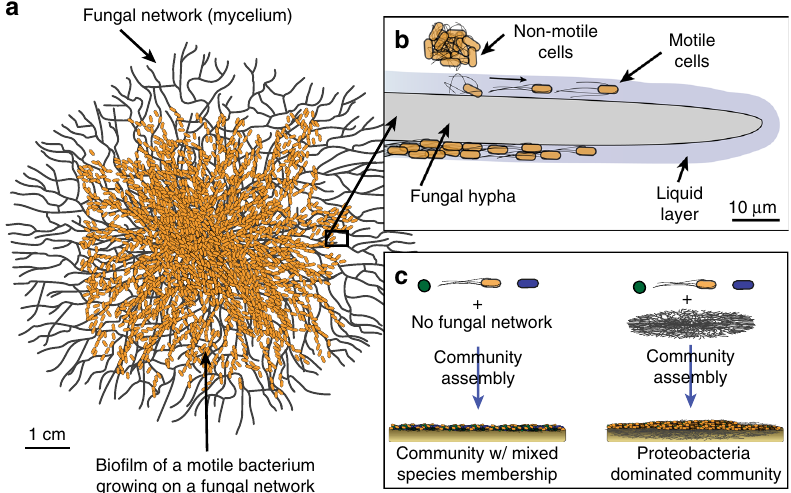
Fig. 5 Overview of mechanisms and consequences of fungal-mediated bacterial dispersal in cheese rind microbiomes. a Cells of motile Proteobacteria spread across fungal networks, leading to increased dispersal across cheese surfaces. b Serratia proteamaculans , and likely other motile Proteobacteria, use fl agella to swim in the liquid layers surrounding Mucor hyphae. c The presence of fungal networks in cheese rind communities leads to the promotion of motile Proteobacteria growth over non-motile community